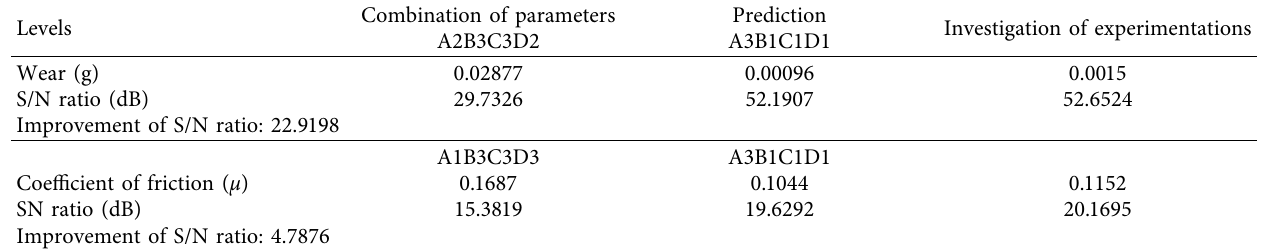
Table 9: Evaluation of best outcomes of confirmation tests.